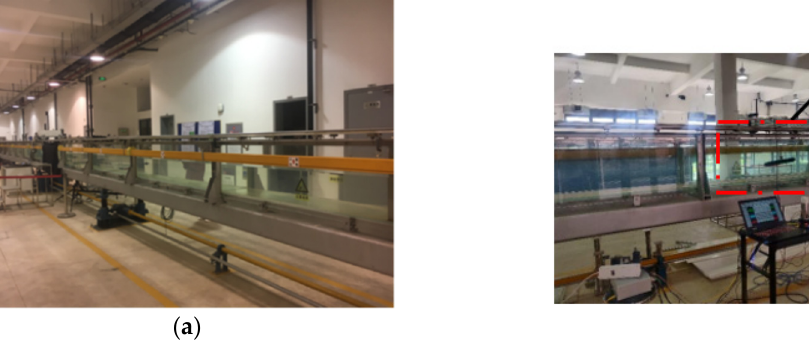
Figure 15. Test scene from a whole view ( a ) and a side view ( b ).